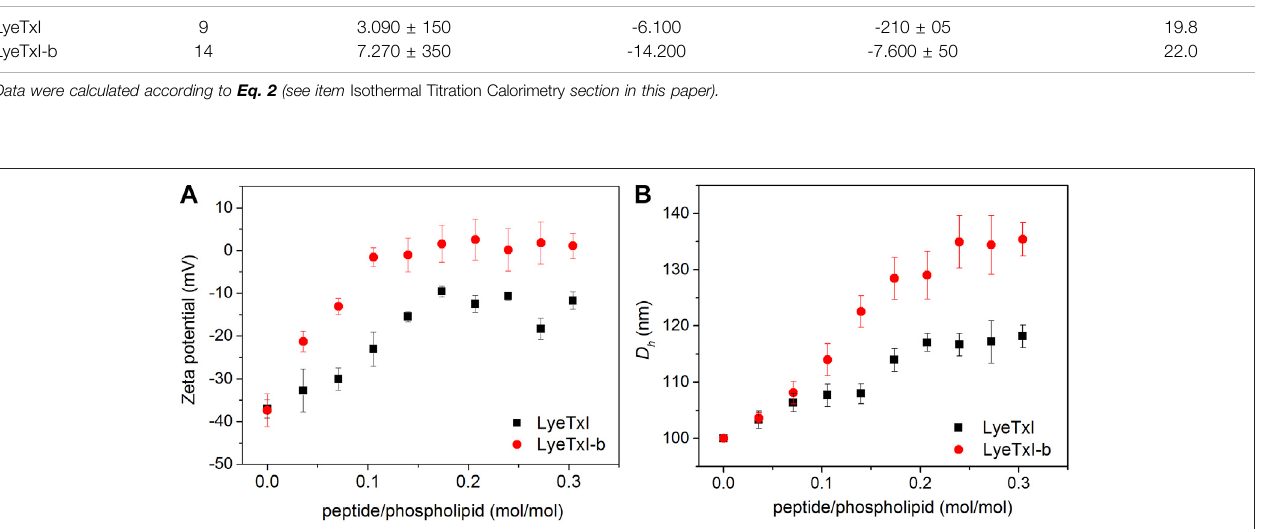
TABLE 2| Thermodynamic parameters obtainedafter onebindingexperiment, non-linear adjustment for25 μ MLyeTxI orLyeTxI-b interaction with20 mM POPC:POPG(3: 1, mol:mol) LUV at 25 ° C.